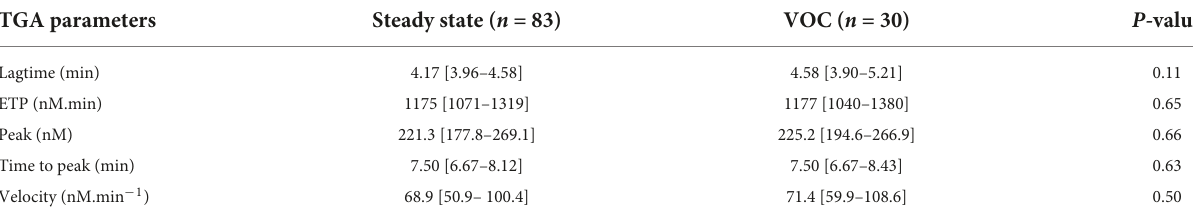
TABLE 4 Comparison of TGA parameters between steady state and